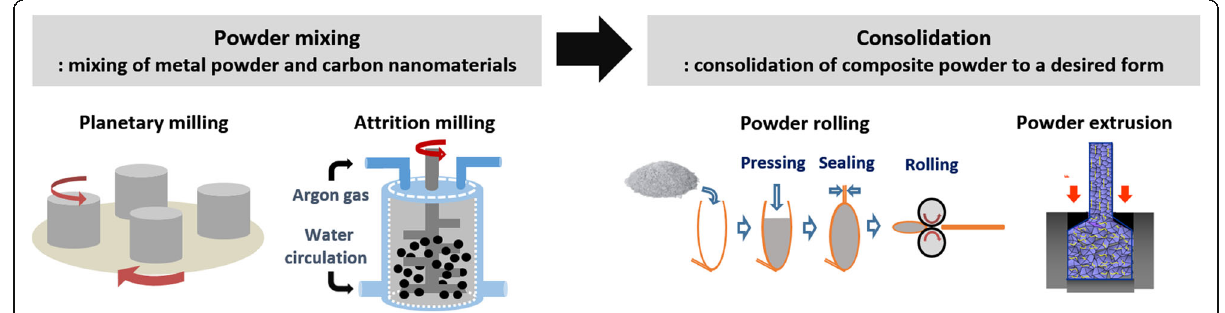
Fig. 3 Typical powder metallurgical routes to produce metal matrix composites containing carbon